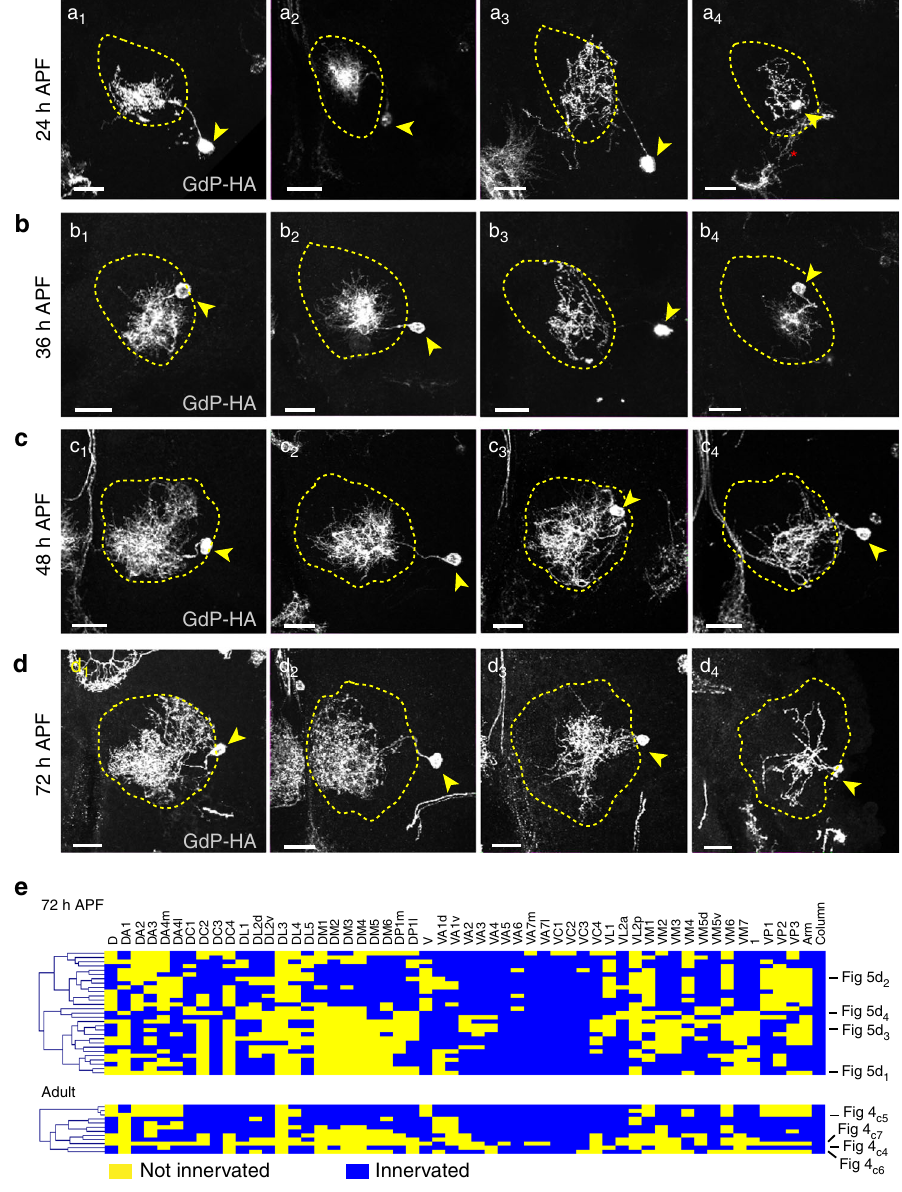
Fig. 5 Morphogenesis of 189-positive larval LNs during pupal development. a – d The same labeling strategy as in Fig. 4c was used to examine the morphologies of 189Y -positive larval LNs in 24 h APF ( n = 50 SCs/154 ALs) a , 36 h APF ( n = 51 SCs/211 ALs) b , 48 h APF ( n = 51 SCs/138 ALs) c and 72 h APF ( n = 32 SCs/121 ALs) d pupal brains. Brains were stained with HA and DNcad (not shown) to visualize neurons and neuropil, respectively. The larval LNs were observed to have processes that densely covered the medioventral region and the dorsolateral region of the AL (a 1 – d 1 ), that are mostly concentrated in the medio-central portion of the AL (a 2 – d 2 ), that innervate the centrolateral portion of the AL (a 3 – d 3 ), or that are sparse and irregular in the AL (a 4 – d 4 ). LNs from each developmental stage were categorized by the similarity of their neurite density, coverage, and occupied regions. LNs shown in a 1 – d 1 , a 2 – d 2 , a 3 – d 3 , and a 4 – d 4 are likely, but not necessarily, of the same type. ALs are contoured by yellow dashed lines. Yellow arrowheads indicate LN soma. Asterisk denotes processes from non-LN cells that are not in the AL. Scale bars, 20 μ m. e Hierarchical clustering of the innervation pro fi les of individual LNs in 72 h APF pupal brains ( n = 29) (top) or adult brains ( n = 12) (bottom). These LNs showed heterogeneous innervation patterns, but fall into four broad